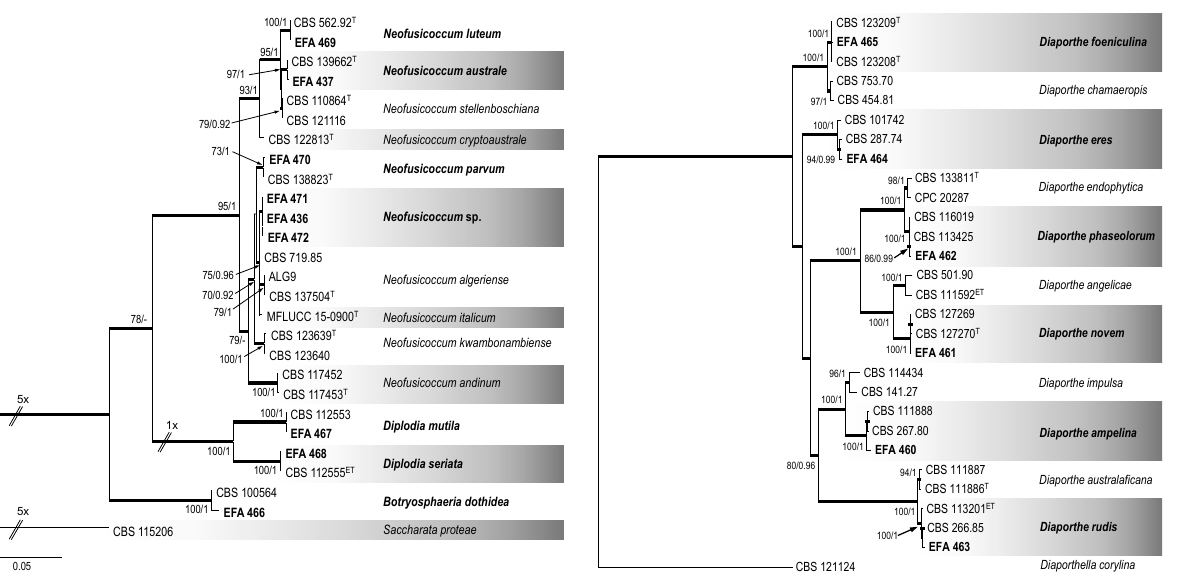
Figure 6. Phylogram generated from Maximum Likelihood analysis of Diaporthe species isolated in this study and their closely related species based on combined ITS, cmdA , his3 , tef1 and tub2 sequence data. Thickened branches are those present in both the maximum likelihood and Bayesian in- ference trees. Bayesian posterior probabilities ≥0.90 and bootstrap support values for ML ≥70% are indicated at the nodes. The tree was rooted to Diaporthella corylina (CBS 121124). Isolates obtained in this study are in bold, ex-type reference strains are indicated with T and ex-epitype refer- ence strains with ET . The scale bar represents the expected changes per site.